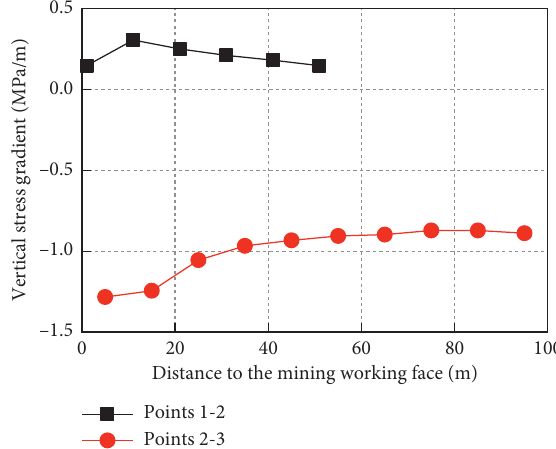
Figure 6: Stress gradient of abnormal stress in front of the mining working